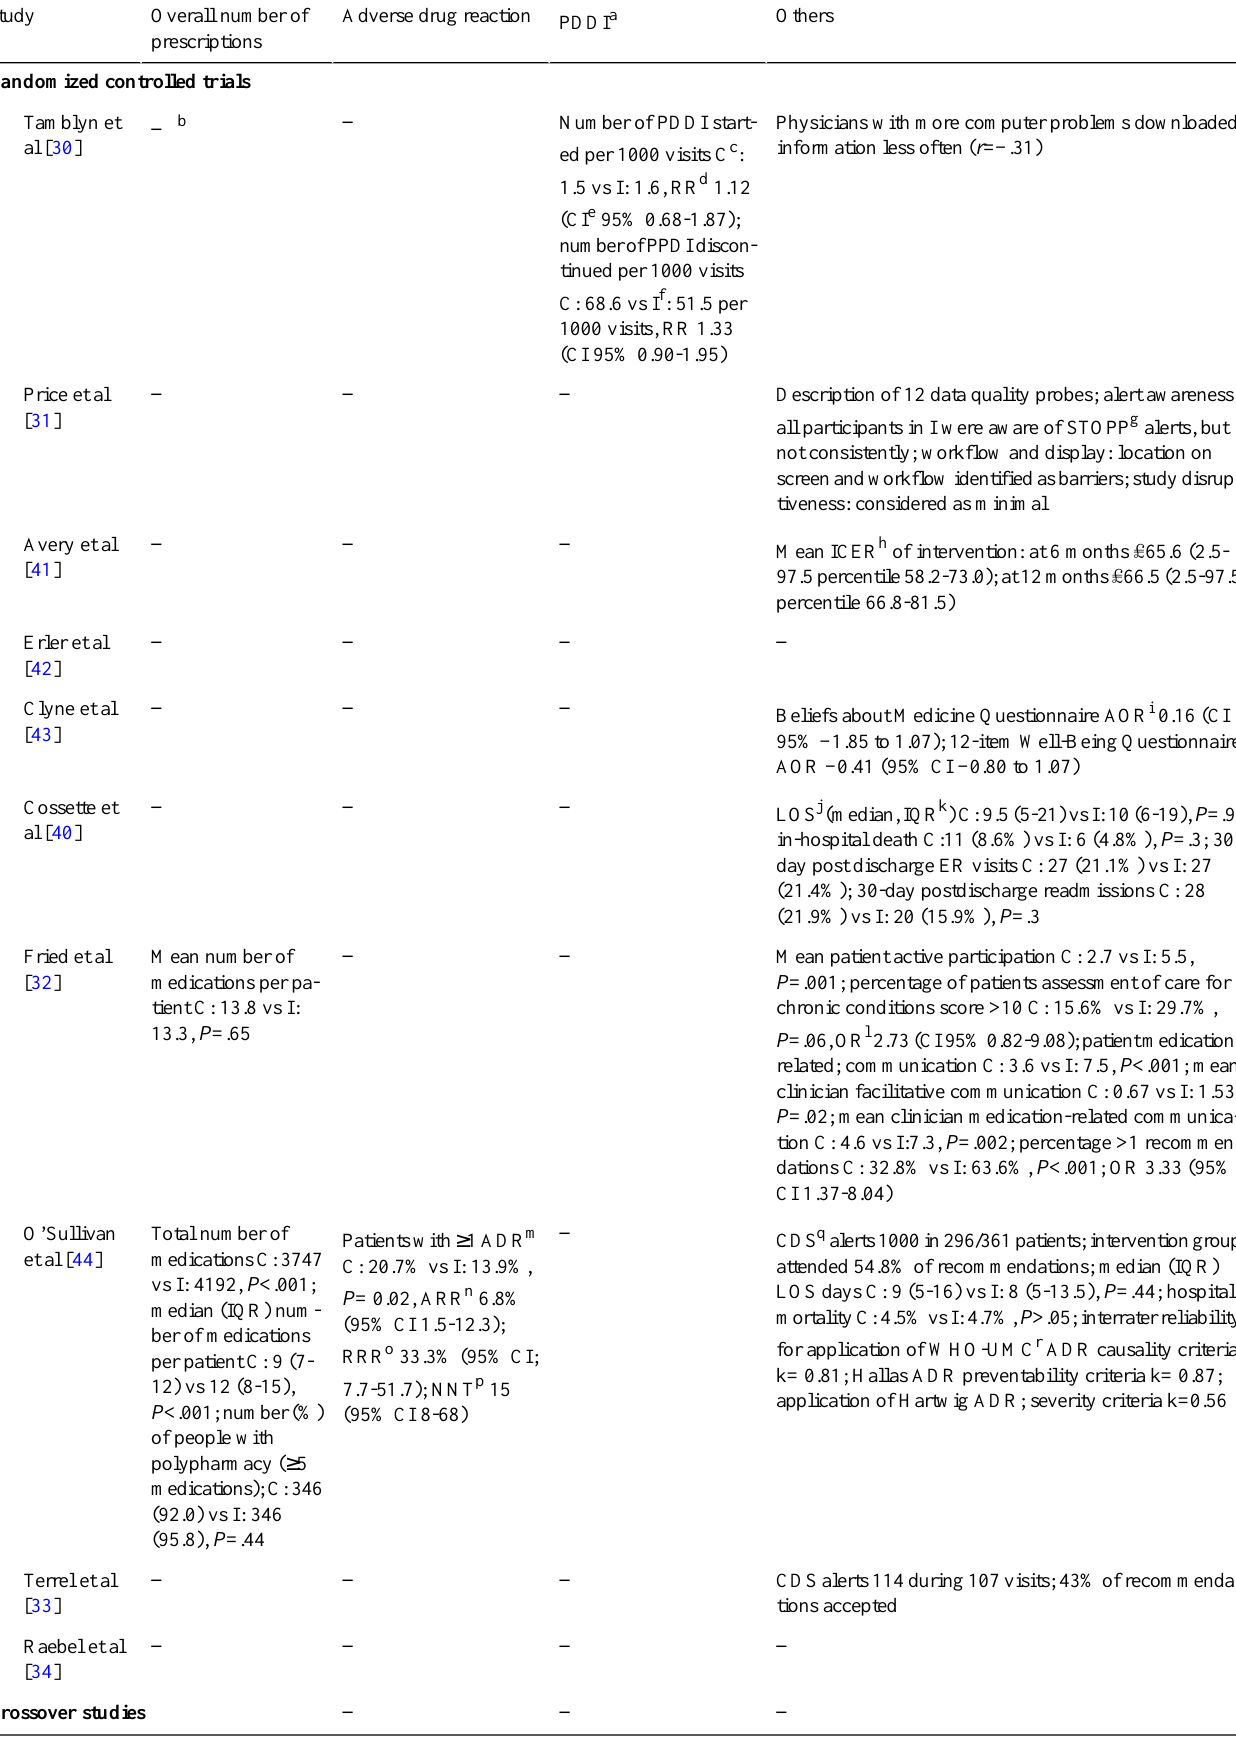
Table 4. Results of the included studies including number of prescriptions, adverse drug reactions, and potential drug-drug interactions